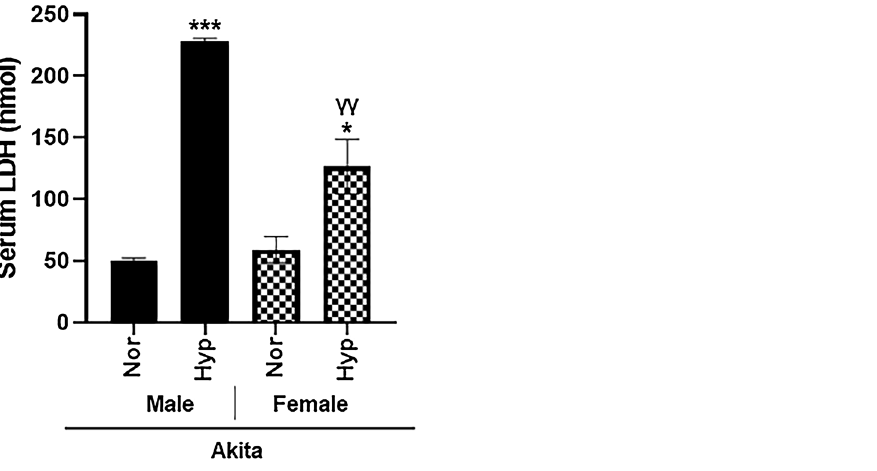
Figure 4. Hyperoxia induce cardiotoxicity in Akita mice as evident by elevated levels of serum LDH in both sexes. Lactic Dehydrogenase (LDH) measured in serum from normoxia and hyperoxia WT and Akita groups. Error bars represent ± SEM. *p < 0.05, **p < 0.005 ***p < 0.0005. *compares effects of hyperoxia and normoxia of same gender and strain; Y compares male and female mice of the same strain and treatment.